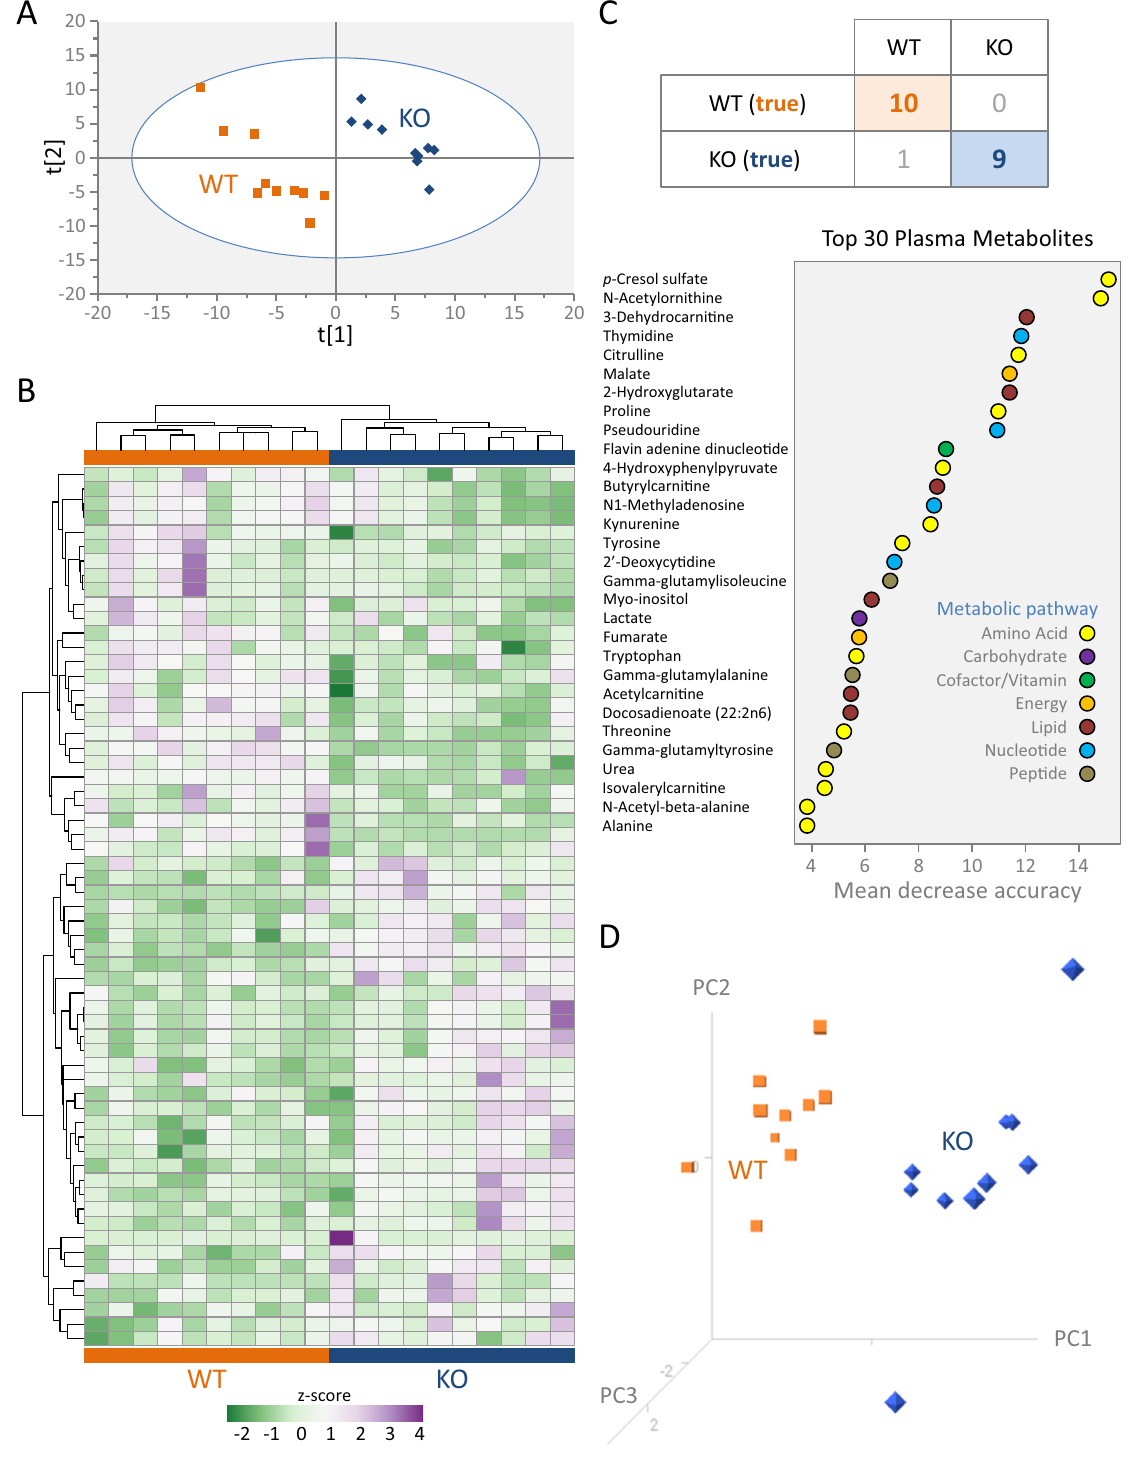
Figure 8. Kir6.2 knockout alters the plasma metabolome. Metabolomic profiling was carried out by liquid and gas chromatography mass spectrometry on plasma from 10 wildtype (WT) and 10 Kir6.2 knockout (KO) animals. ( A ) Supervised classification of the 257 identified plasma metabolites by partial least squares—discriminant analysis documented separation between KO and WT, ranking metabolites based on variable importance in projection scores. ( B ) Nearly one quarter of the resolved plasma metabolome (61/257 metabolites, or 23.7%) was differentially expressed in KO relative to WT, with 34 upregulated (purple) and 27 downregulated (green), separating cohorts by z-score transformed agglomerative clustering by correlation distance and average linkage. ( C ) Random Forest ensembles of decision trees documented 95% accuracy in predictive classification of WT and KO. The 30 differential plasma metabolites exhibiting the largest contribution to classification, rank ordered by mean decrease accuracy scores, spanned metabolic pathways. ( D ) Documenting the discriminatory resolution of differential plasma metabolites, singular value decomposition 3-D principal component analysis segregated KO from